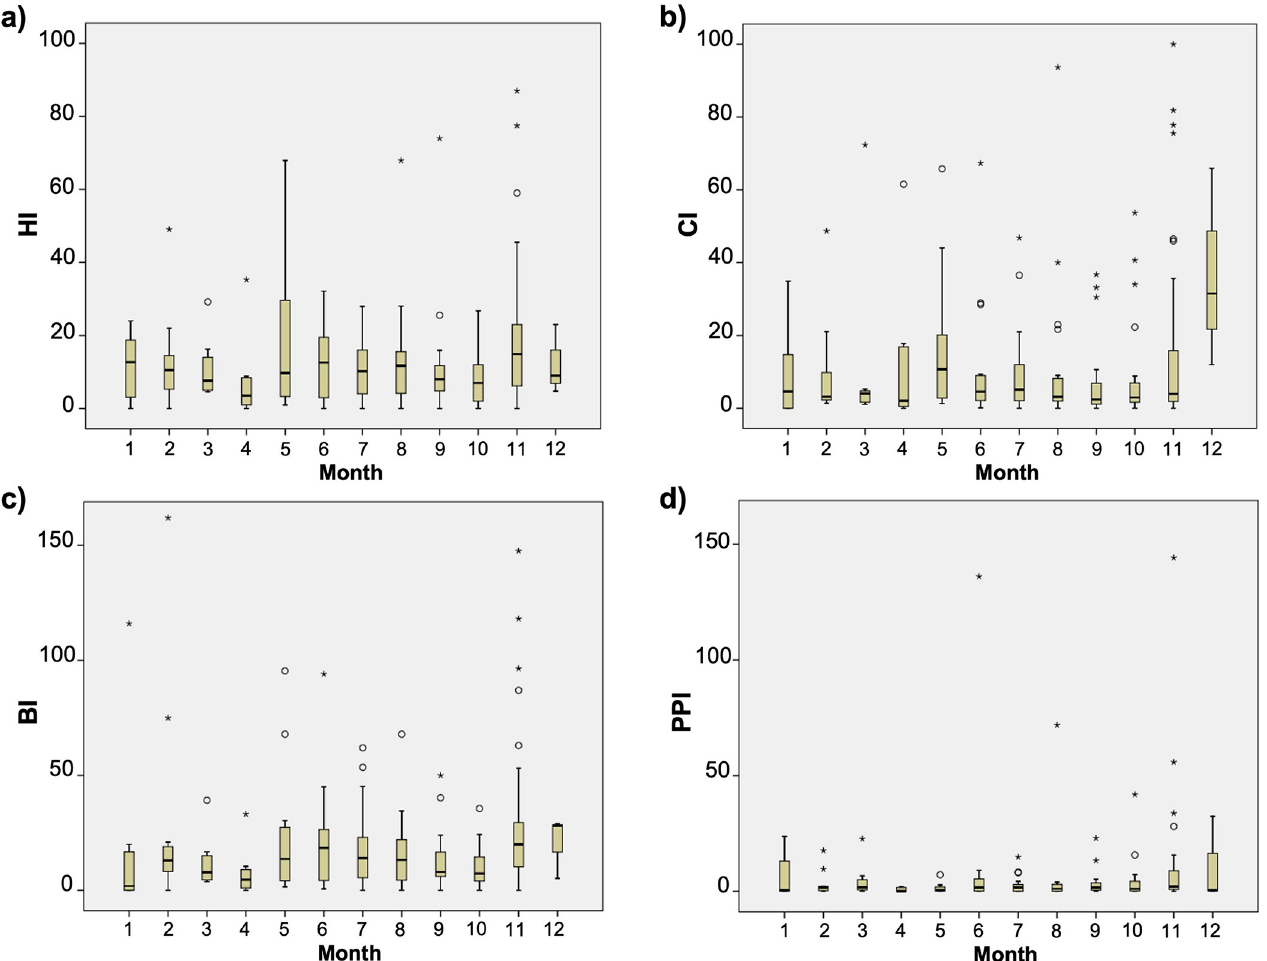
Fig 4. Monthly trend in vector indices across city/ municipality areas, 2013–2018. Monthly averages of a) House Index, b) Container Index, c) Breteau Index and d) Pupal Productivity Index are shown for all areas where data was collected between 2013 and 2018. Month numbers 1–12 on the x axis correspond to the months